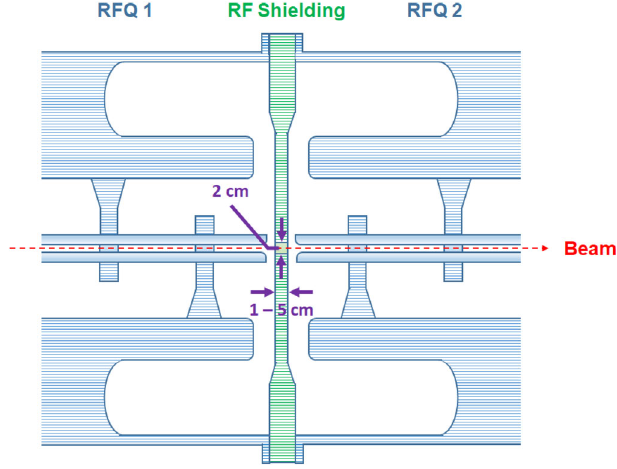
FIG. 10. Schematic plot of the connection between two RFQs for 5 cm ≤ d ≤ 8